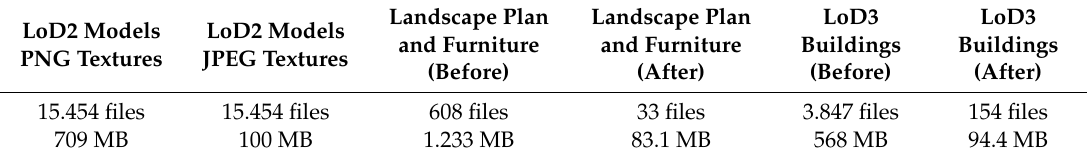
Table 2. Comparison of the number of the texture images and the total file sizes before and after optimization.